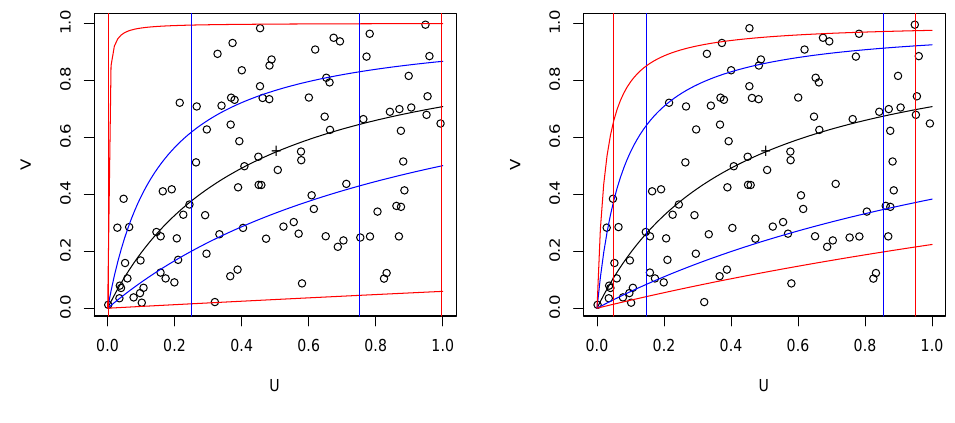
Figure 5: BBP in options 1 (left) and 2 (right) for the Clayton copula in Example 2.2 with 100 simulated data.